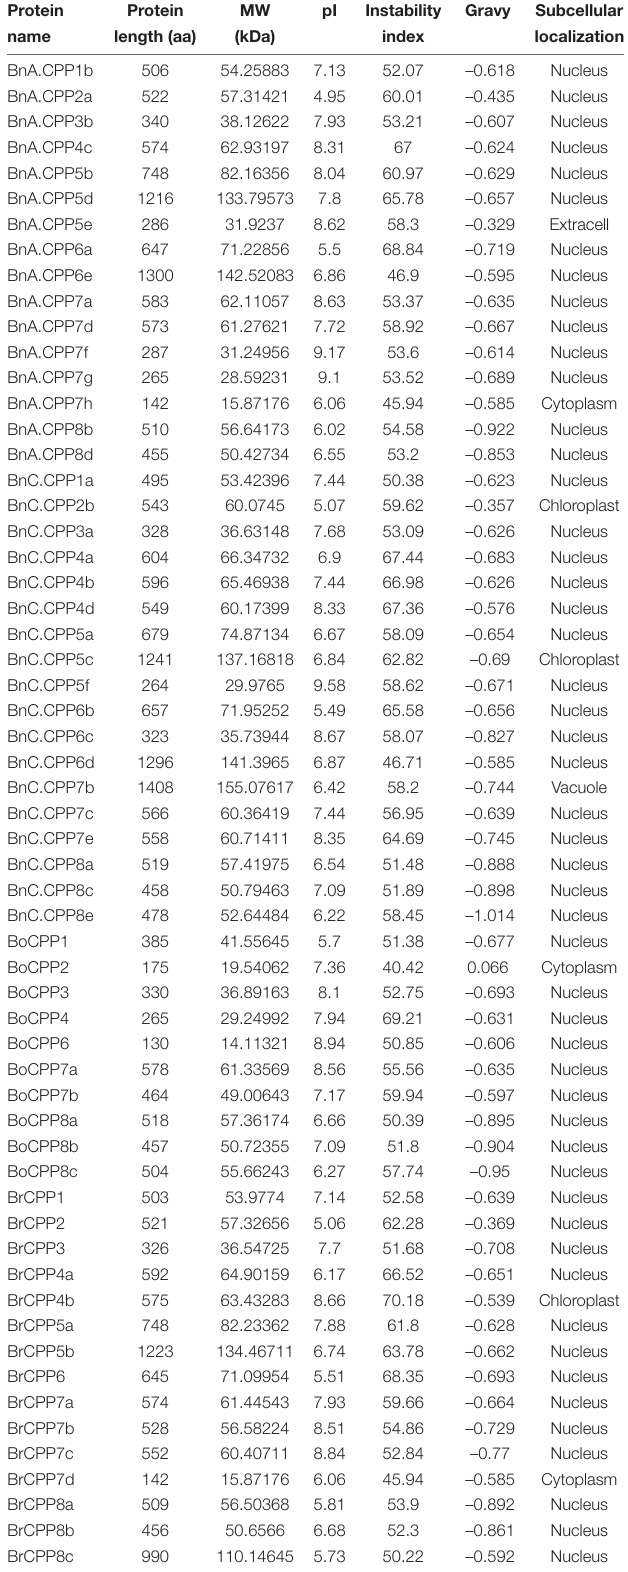
TABLE 3 | The physicochemical parameters and subcellular localization prediction of CPP proteins in B. napus and its diploid progenitors. Protein Protein MW pI Instability Gravy